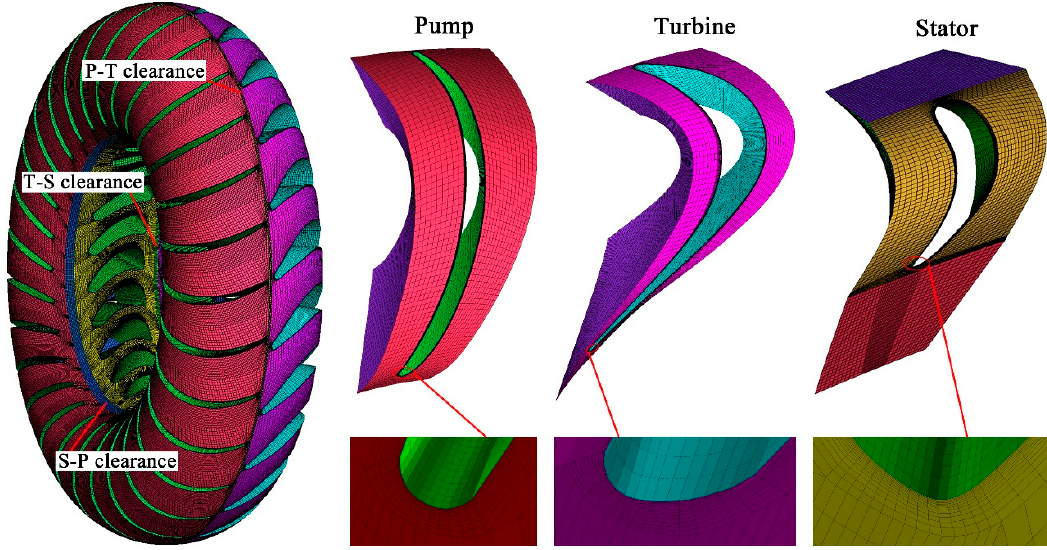
Figure 4. Structural mesh model of the hydrodynamic torque converter.